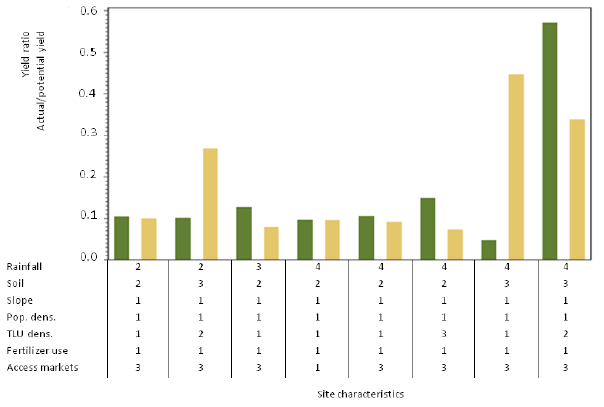
Figure 7. Comparing yields under “low” (green) and “severe” (sandy brown) degradation for uniform sites defined by six vari- ables (rainfall, soil, slope, population, TLU, markets) for “low” fertilizer applications. Codes on x axis for rainfall are 1 = <200; 2 = 200–400; 3 = 400–700; 4 = >700mm; for soils 1 = unsuitable; 2 = not suitable; 3 = moderately suitable; 4 = suitable; for slope 1 = no slope ; 2 = undulating; for population density 1 = <600; 2 = 600–9000; 3 = >9000pkm − 2 ; for TLU density 1 = <21; 2 = 21–32; 3 = >32TLUkm − 2 ; fertilizer use 1 = <50; 2 = 50– 150; 3 = >150kgha − 1 ; and for access to markets 1 = 1. cat. road<10km; 2 = 2. cat. road<10km; 3 = 3. cat. road<10km; 4 = >10km.